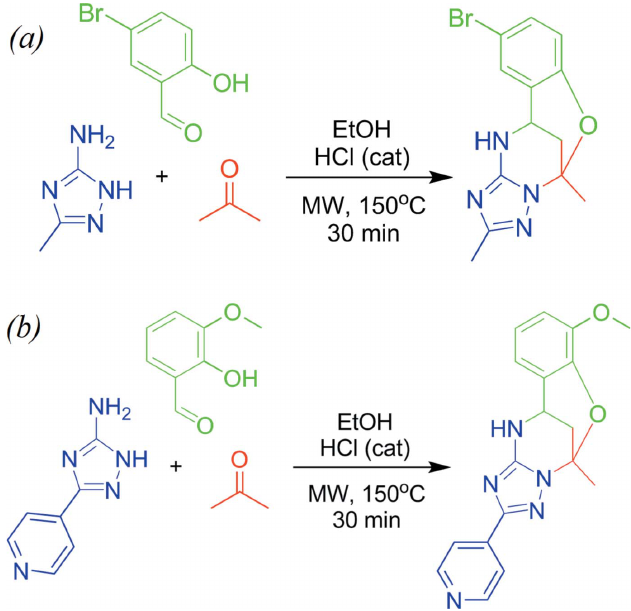
Figure 10 The synthesis of ( a ) compound I and ( b ) compound II